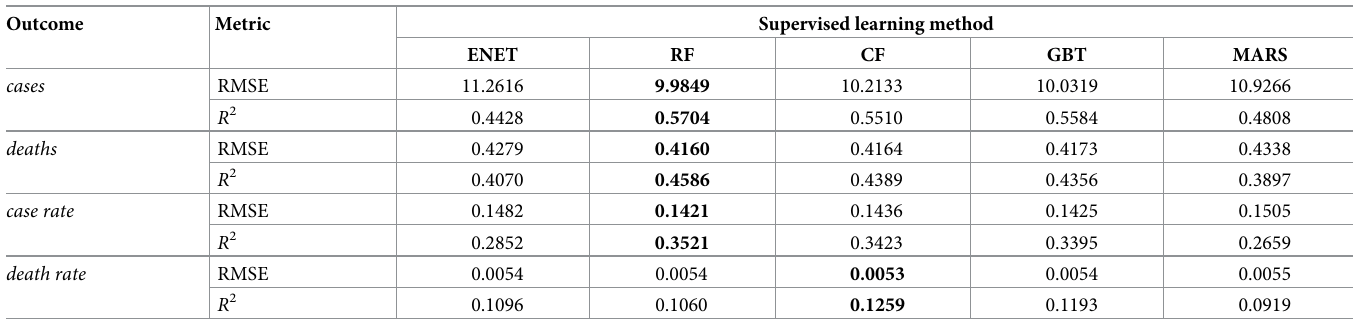
Table 2. Model performance.